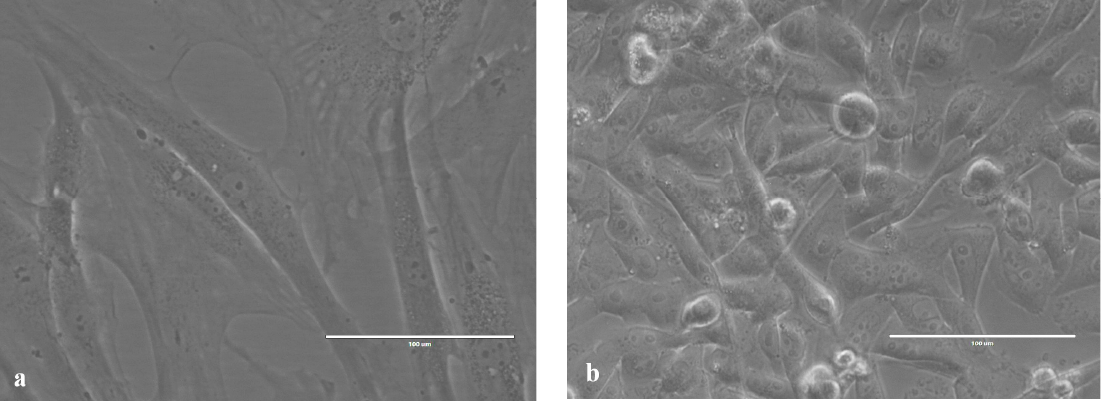
Figure 1. ( a ) Adipose-derived mesenchymal stem cells; ( b ) human osteosarcoma cells.